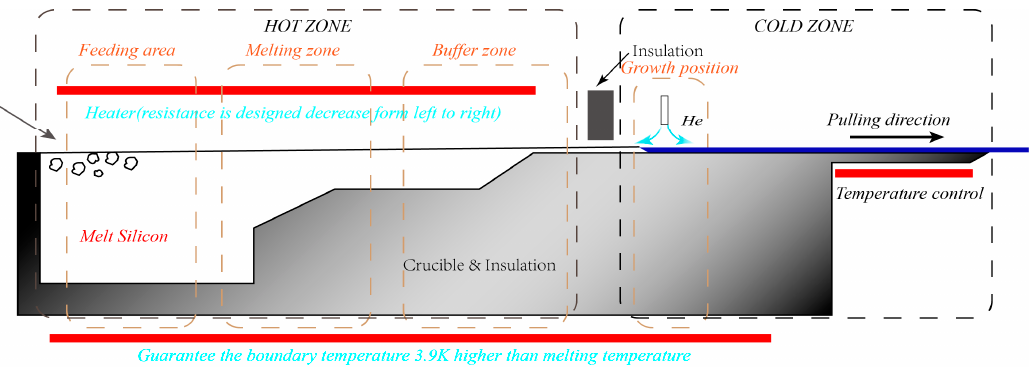
Figure 1. Schematic diagram of the experimental configuration.